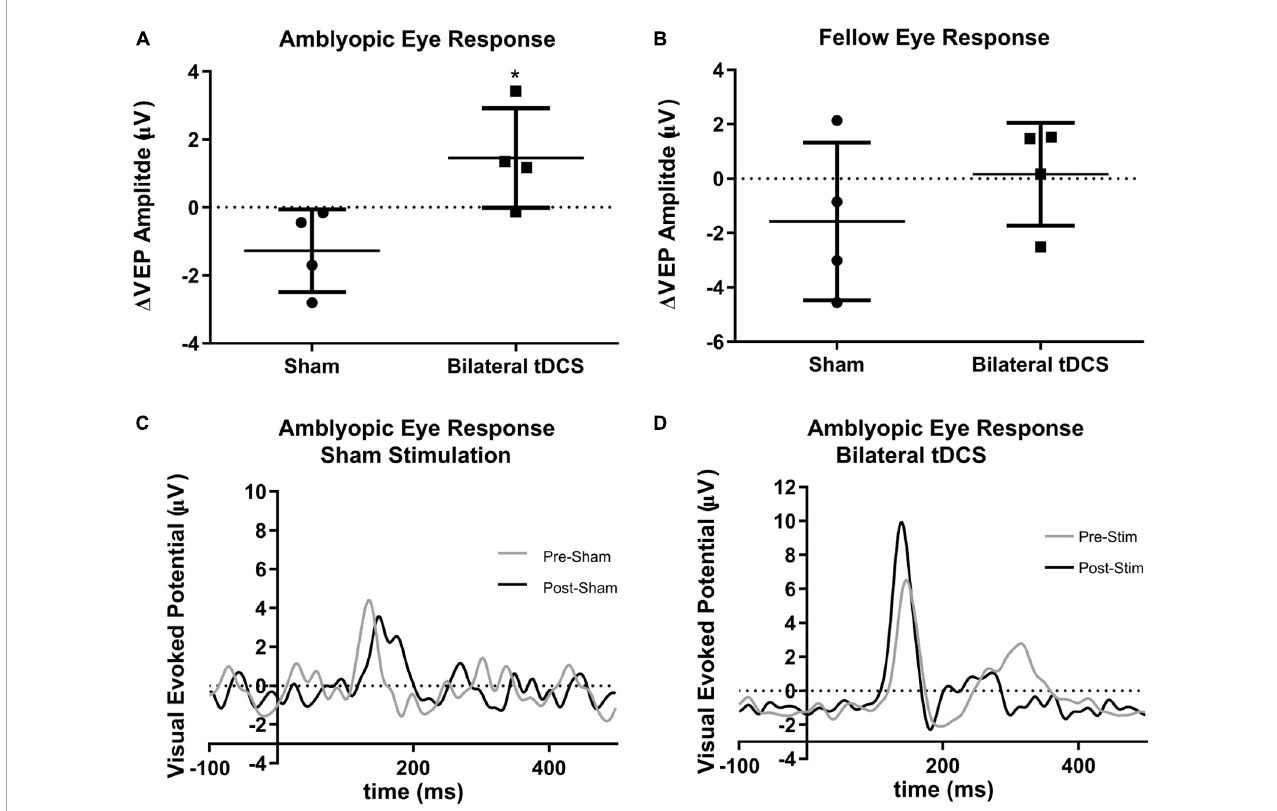
FIGURE3 Effect of transcranial direct current stimulation (tDCS) in the visual evoked potential (VEP) amplitude of the fellow and amblyopic eye response. Bilateral tDCS does not change the VEP amplitude of fellow eye response (A) but increases the amplitude in the amblyopic eye response (B)